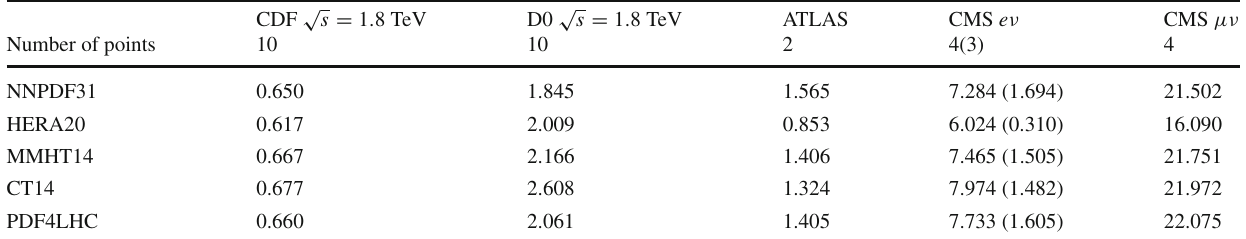
Table 1 χ 2 / N using the extraction of TMD of [35]. For the CMS case W → e ν in parenthesis we also report the χ 2 with one less point as explained in text